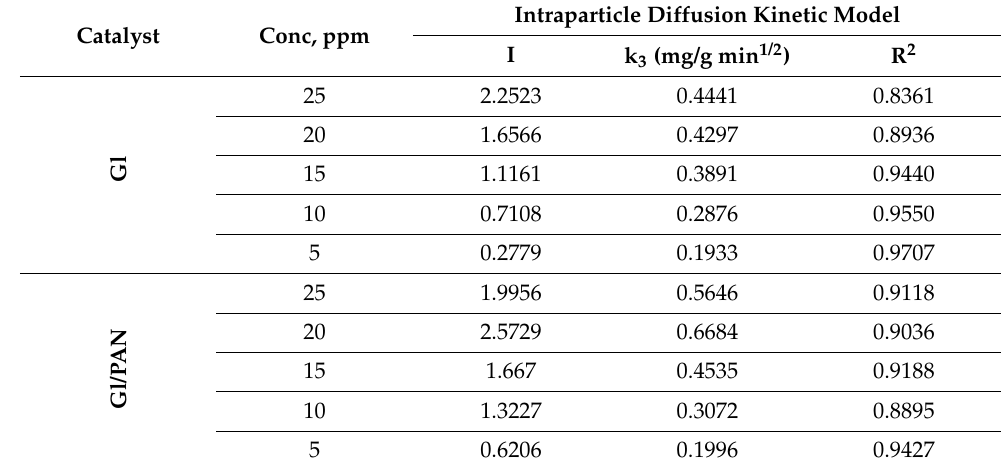
Figure 8. Intra-particle sorption kinetics of CR dye at 25 ◦ C and pH 7 by 20 mg of ( a ) Gl and ( b ) Gl/PAN composite. Table 4. Intra-particle diffusion constants for different initial CR concentrations at 25 ◦